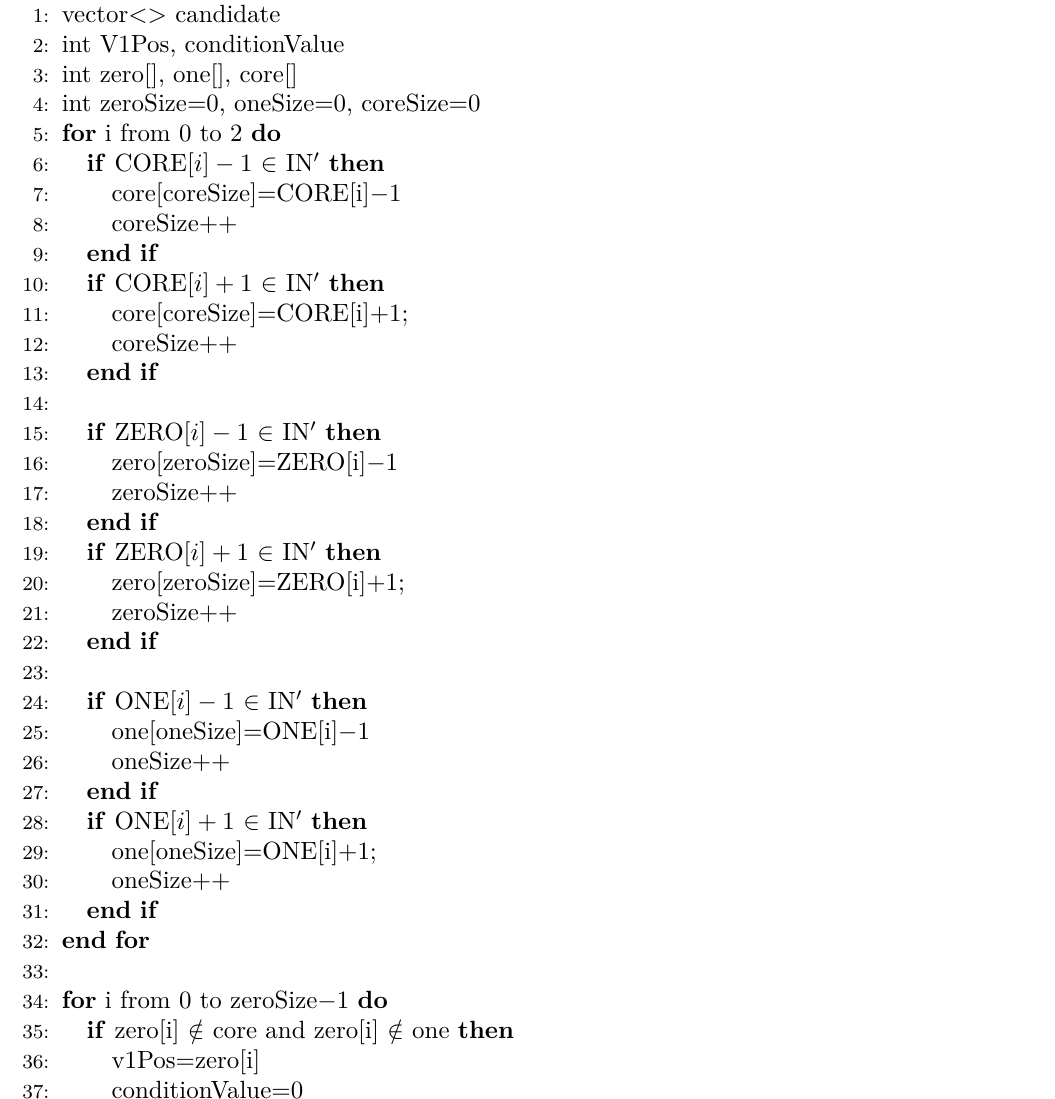
Algorithm 6 Determine candidates of cube variables for TYPE-I conditional cube